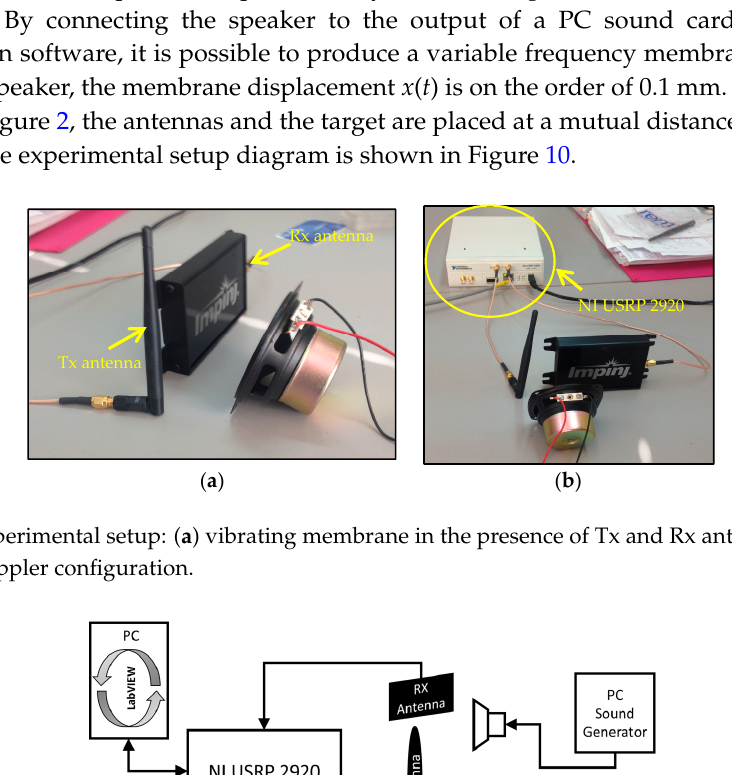
Figure 10. Experimental setup diagram.